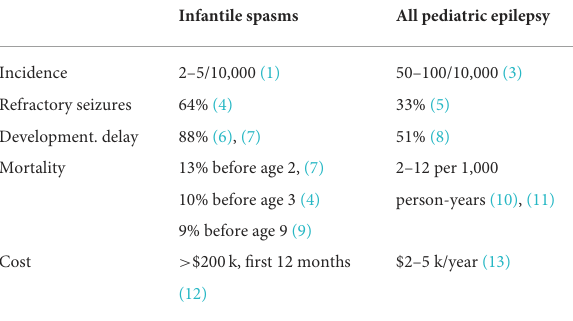
TABLE 1 Compared to all pediatric epilepsies, infantile epileptic spasms syndrome is rare, but it has high rates of refractory seizures, developmental delay, mortality, and treatment